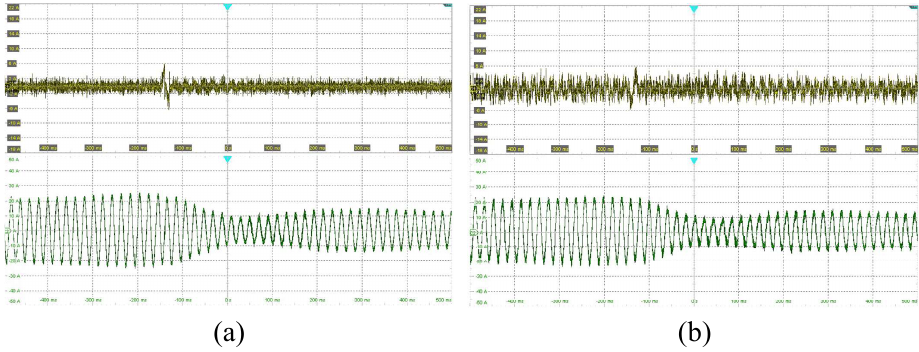
Figure 23. Thetracking error and the grid current when the controller is used at 49 Hz. ( a ) VVS. ( b )